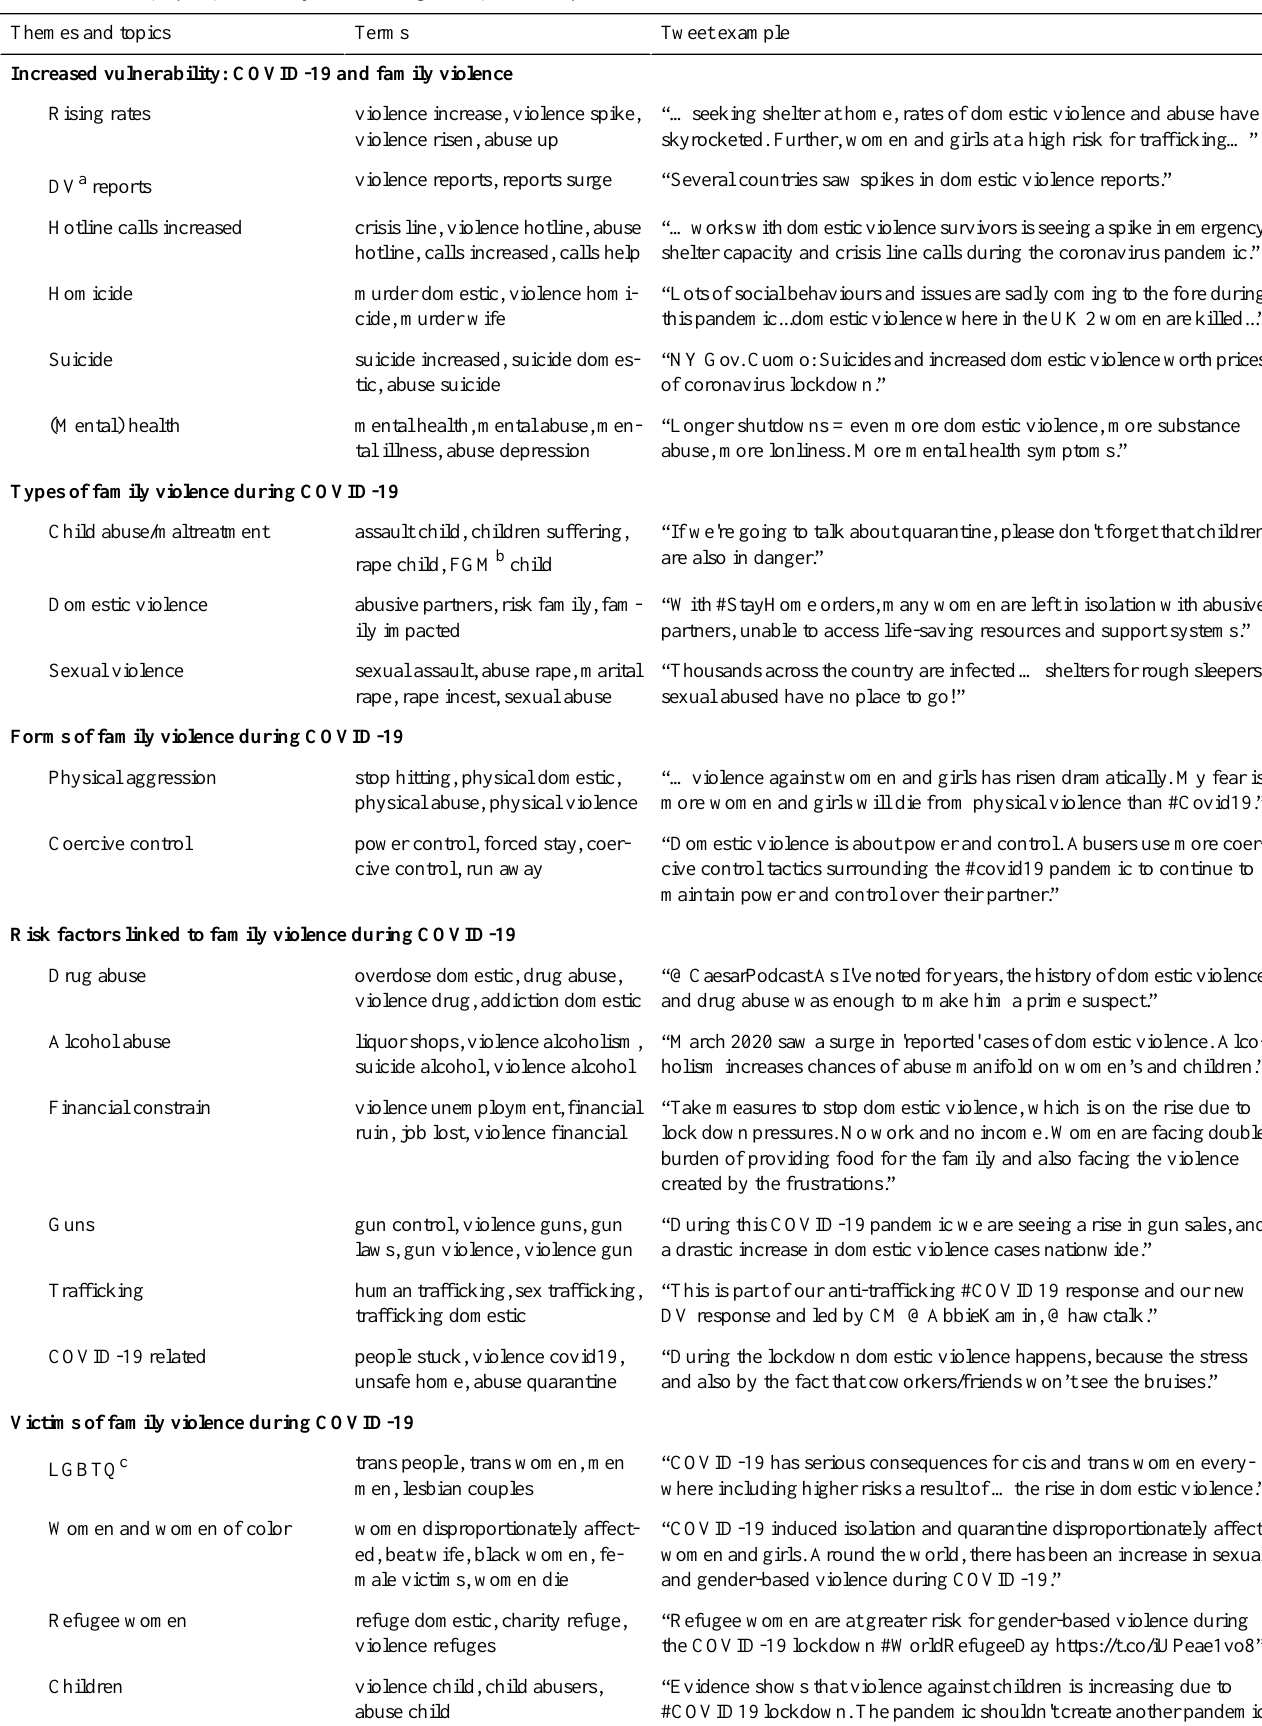
Tweet exampleTermsThemes and topics